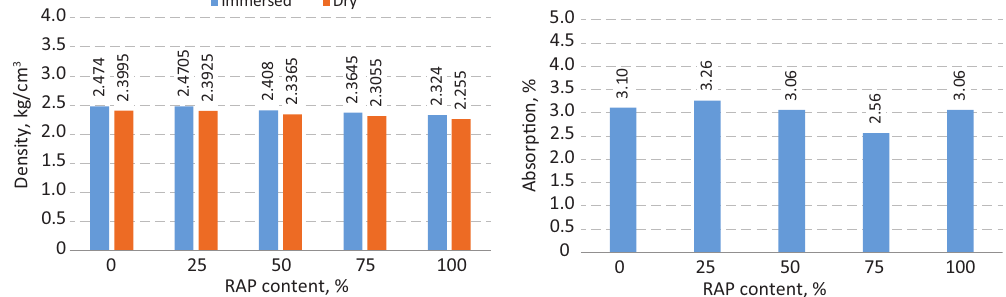
Figure 17. Density (right) and water absorption (left) of the RCC mixtures containing